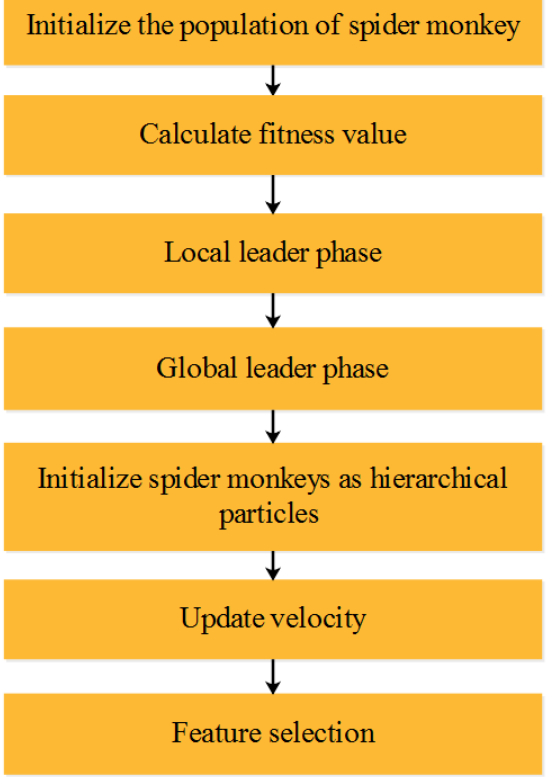
Figure 3. Steps involved in hybrid feature selection algorithm.